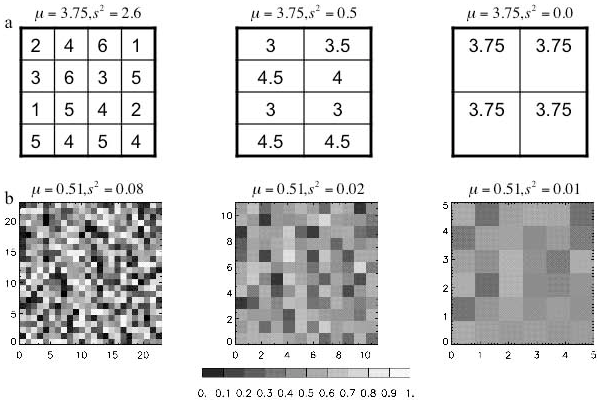
Fig. 3. Change in variance s 2 with aggregation of two simple datasets (a) from Jelinski and Wu (1996) and (b) randomly gen- erated numbers. Note the constant value for the mean µ in each case as the variance decreases with